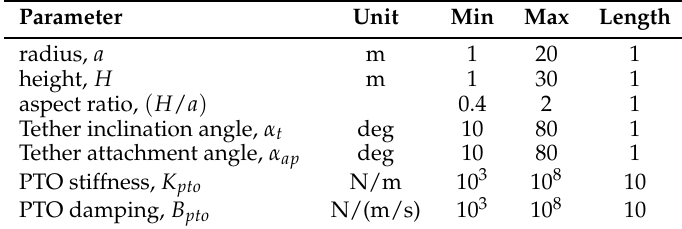
Table 2. Boundary constraints of the cylinder parameters.